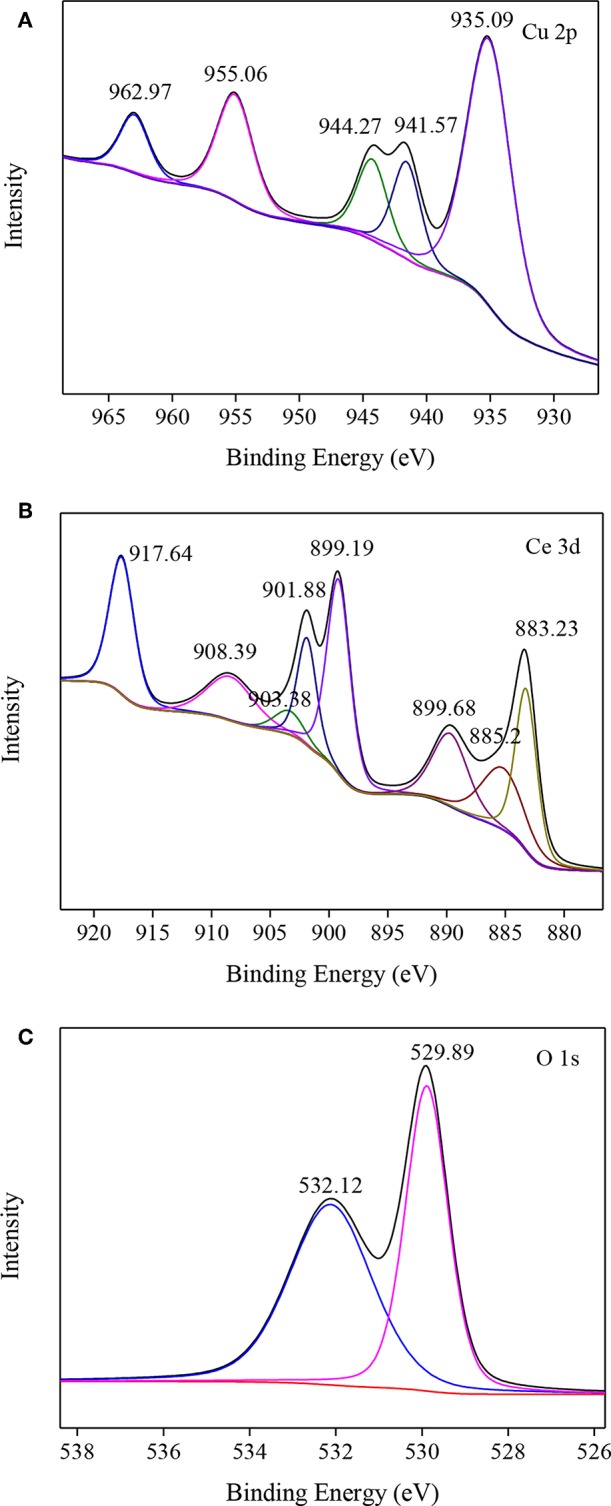
XPS spectra of (A) Cu 2p, (B) Ce 3d, and (C) O 1s in CuO/CeO2.